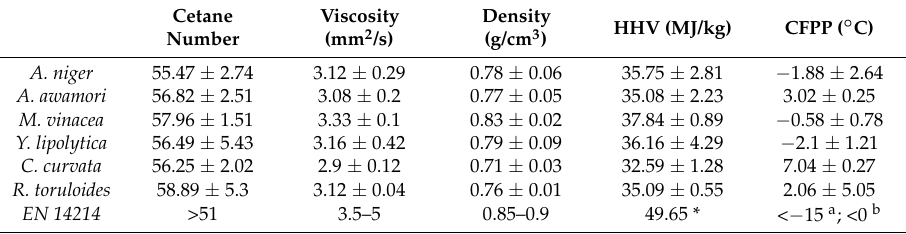
Table 4. Biodiesel properties of six selected strains determined from the composition of the